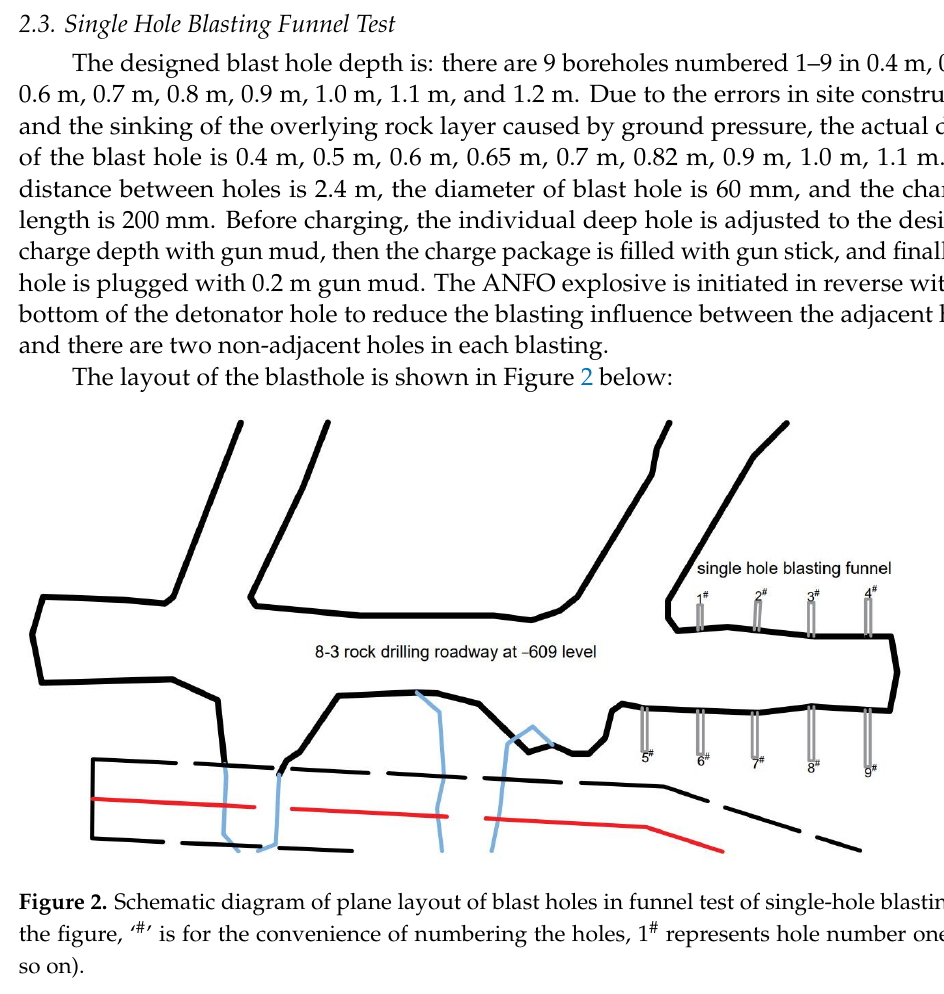
Figure 3. Schematic diagram of blast hole plane layout in funnel test of multi-hole blasting with variable hole distance. (In the figure, ‘ # ’ is for the convenience of numbering the holes, 10 # repre- sents hole number one, and so on ) 2.5. Inclined Bench Blasting Test The design scheme is shown in Figure 4, and the blasthole layout is shown in Figure 5 below: